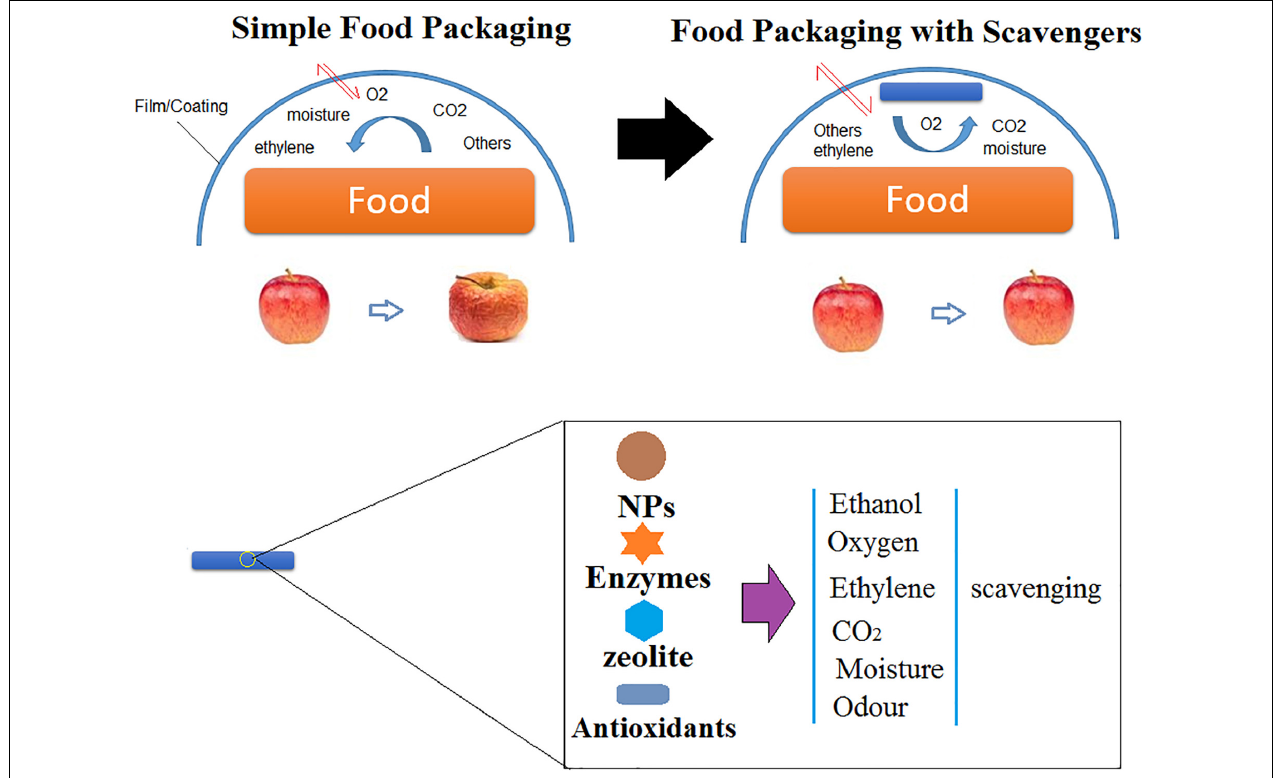
FIGURE 6 | Embedding scavengers in